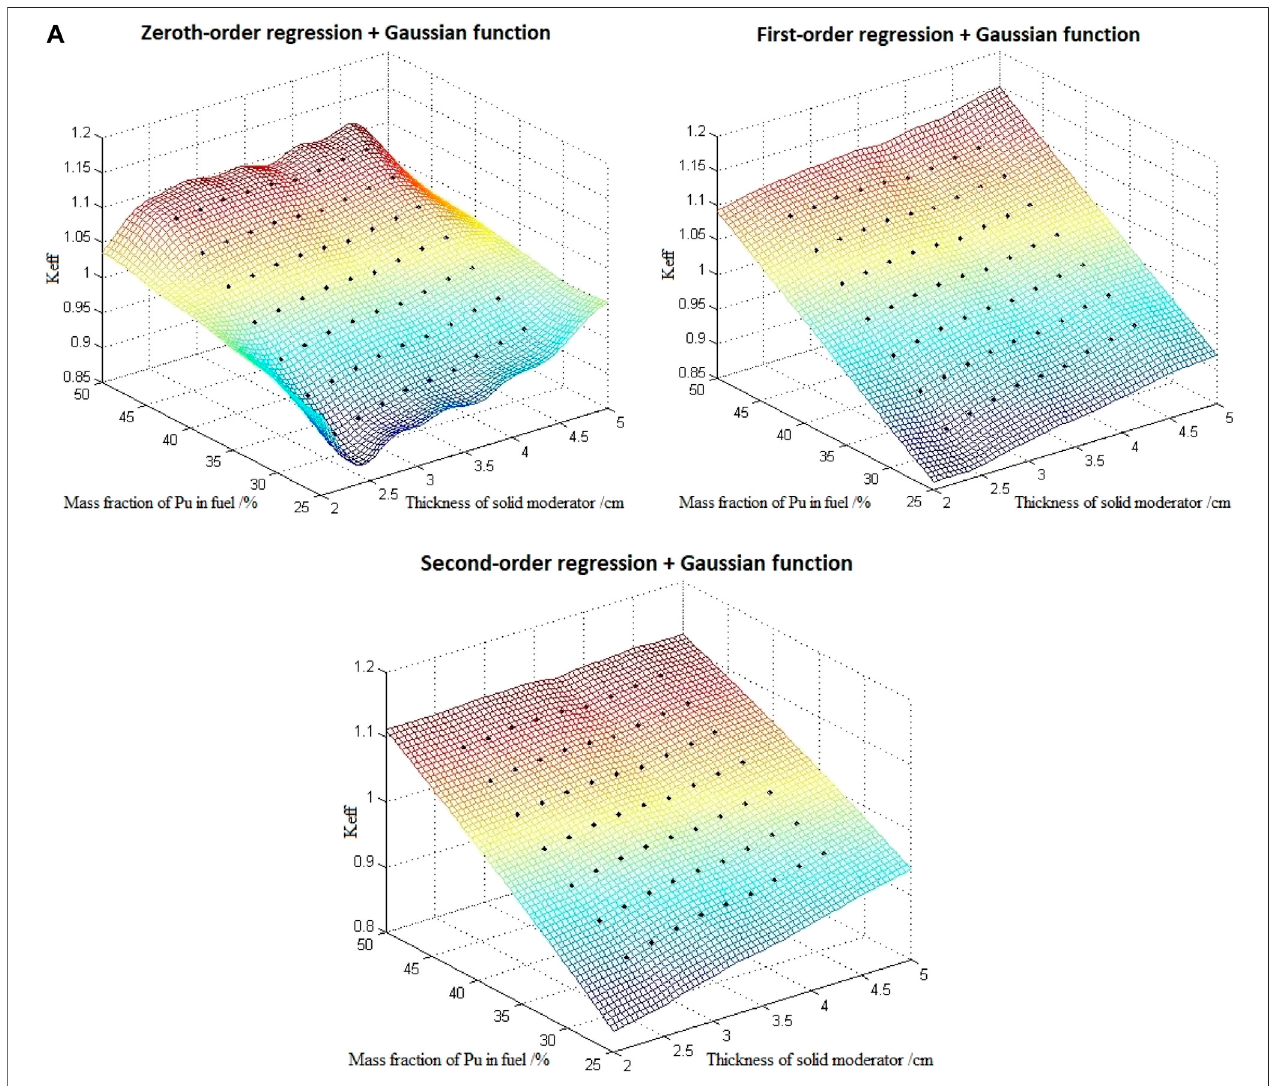
FIGURE 2 | Construction records of KSM, OLHS, and SEUMRE. (A) Fitting effect of KSM constructed by different regression models with Gaussian function, (B) FittingeffectofKSMconstructedbydifferentcorrelationfunctionwithsecond-orderregressionmodel, (C) MSEofKSMconstructedbyexponential/Gaussiancorrelation function with second-order regression model, (D) Comparison between ordinary LHS and OLHS distribution, (E) Flow diagram of SEUMRE algorithm.